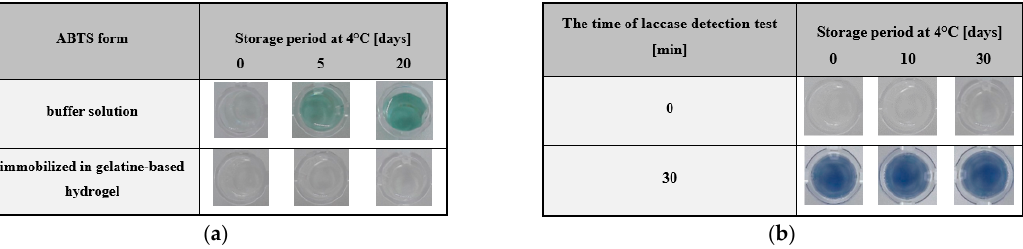
Figure 6. Evaluation of storage stability for ABTS—a substrate used for determination of laccase activity in a gelatine hydrogel-based colourimetric test. ABTS was tested in its native form in a phosphate-citrate buffer solution at pH 5.2 ( a ), and as immobilised in a hydrogel matrix after 0–20 days ( b ). Storage stability of gelatine hydrogel test with immobilised ABTS was performed after 30 days. Laccase detection assays were compared after 30 min of colourimetric test applying enzyme concentration of 100 µg/mL. Experimental conditions: 4 °C, and with 1.5 mg/mL of ABTS.